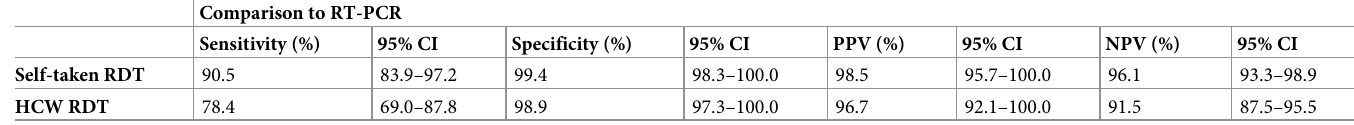
Table 2. Sensitivity and specificity of self- and healthcare worker-taken swabs for COVID-19 rapid diagnostic testing. Comparison to